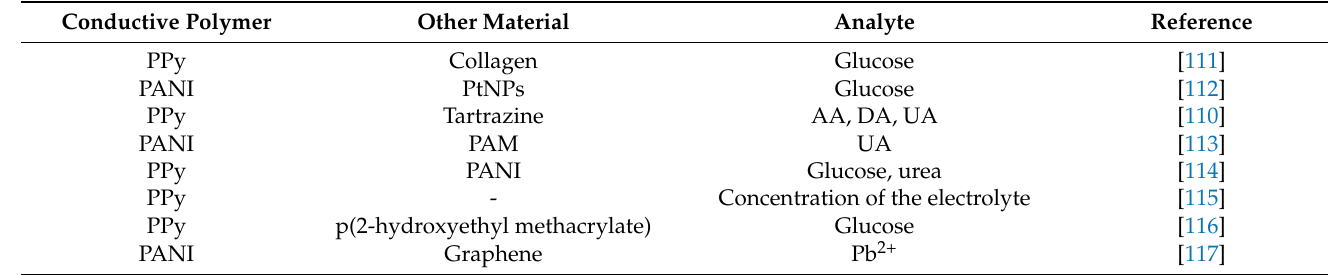
Figure 6. The fabrication process of PPy hydrogel for electrochemical determination of AA, DA, UA [110]. Copyright: Elsevier B.V. Table 2. Summary of conductive polymer-based hydrogel for electrochemical sensing.